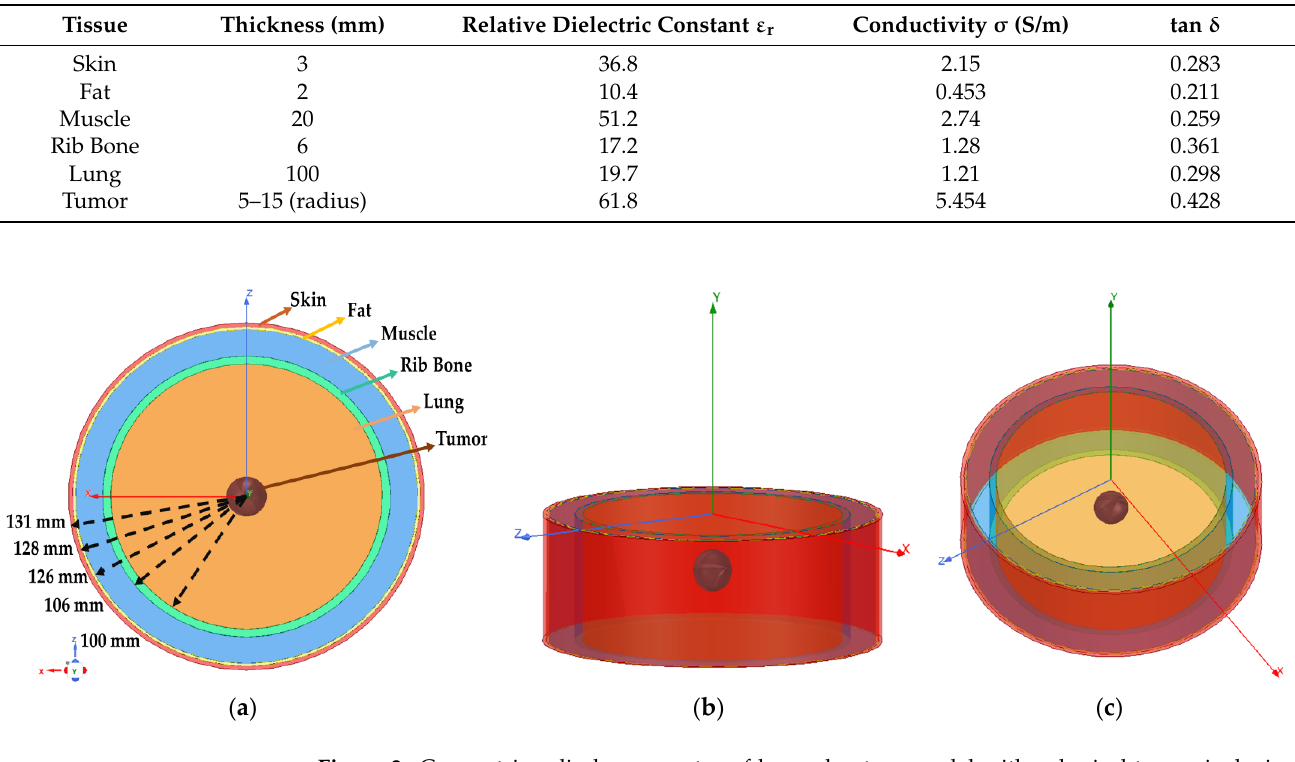
Table 2. Physical and dielectric properties of lung phantom with tumor inclusion.